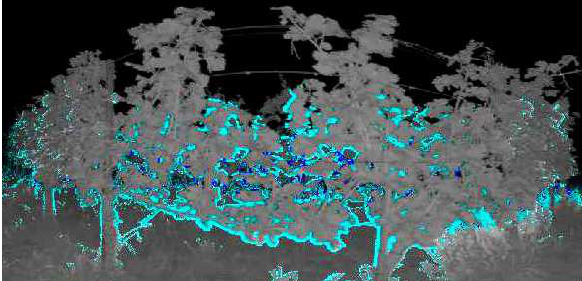
Figure 3: Intensity image with highlighted areas arising from multiple echoes at edges.